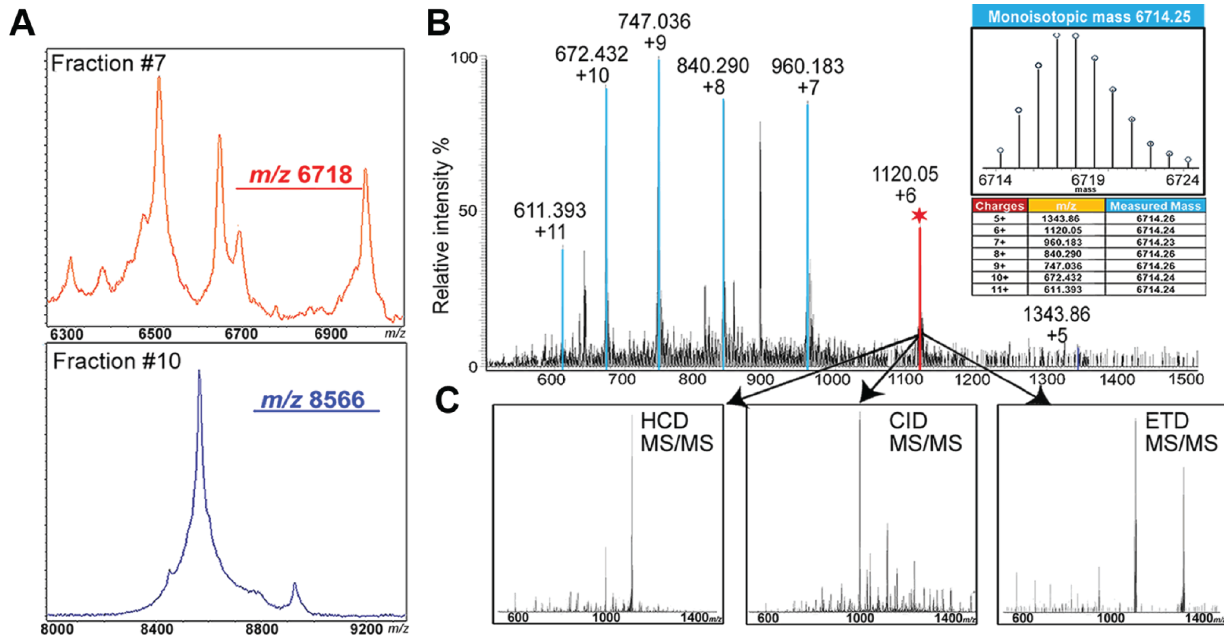
Figure 5. The workflow to identify the proteins that displayed changes in the MK801-treated samples. (A) MALDI-MS screening spectra of the HPLC fractions that contained the concentrated proteins of interest at m/z 6718 and 8566. (B) Representative MS spectrum acquired from a HPLC fraction containing the m/z 6718 ion on an ESI-Orbitrap Elite system, which provides ultra-high mass resolution and accuracy. The insert is the deconvoluted spectrum averaged from several multiply charged ion forms as highlighted in blue and red. (C) HCD, CID and ETD tandem MS fragmentation spectra of the particular ion at m/z 1120.05 (z=6) highlighted in red.